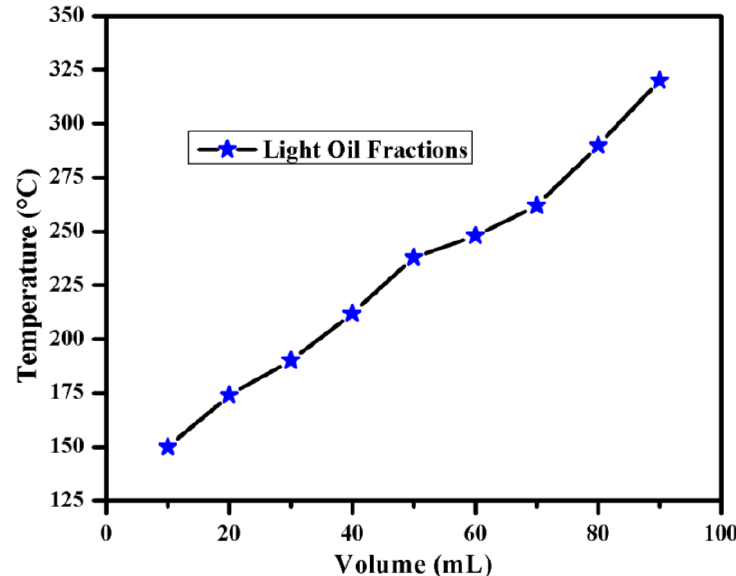
Figure 4. Distillation of Light Oil Fraction.